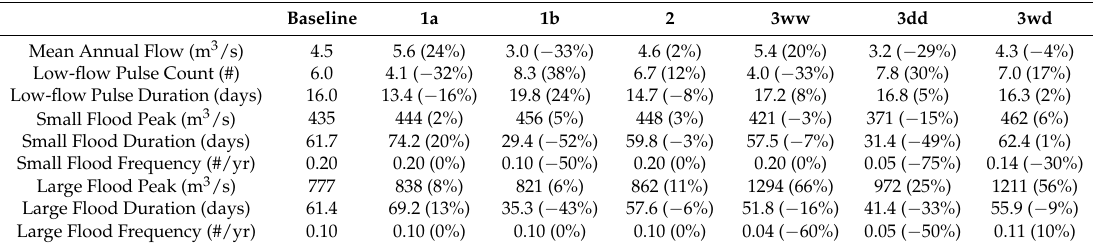
Table 4. Nine hydrologic indexes calculated from SWAT-simulated daily streamflow for the baseline and six future climate scenarios for the mid-21st century projection (2046–2065). The percentage in brackets shows change from